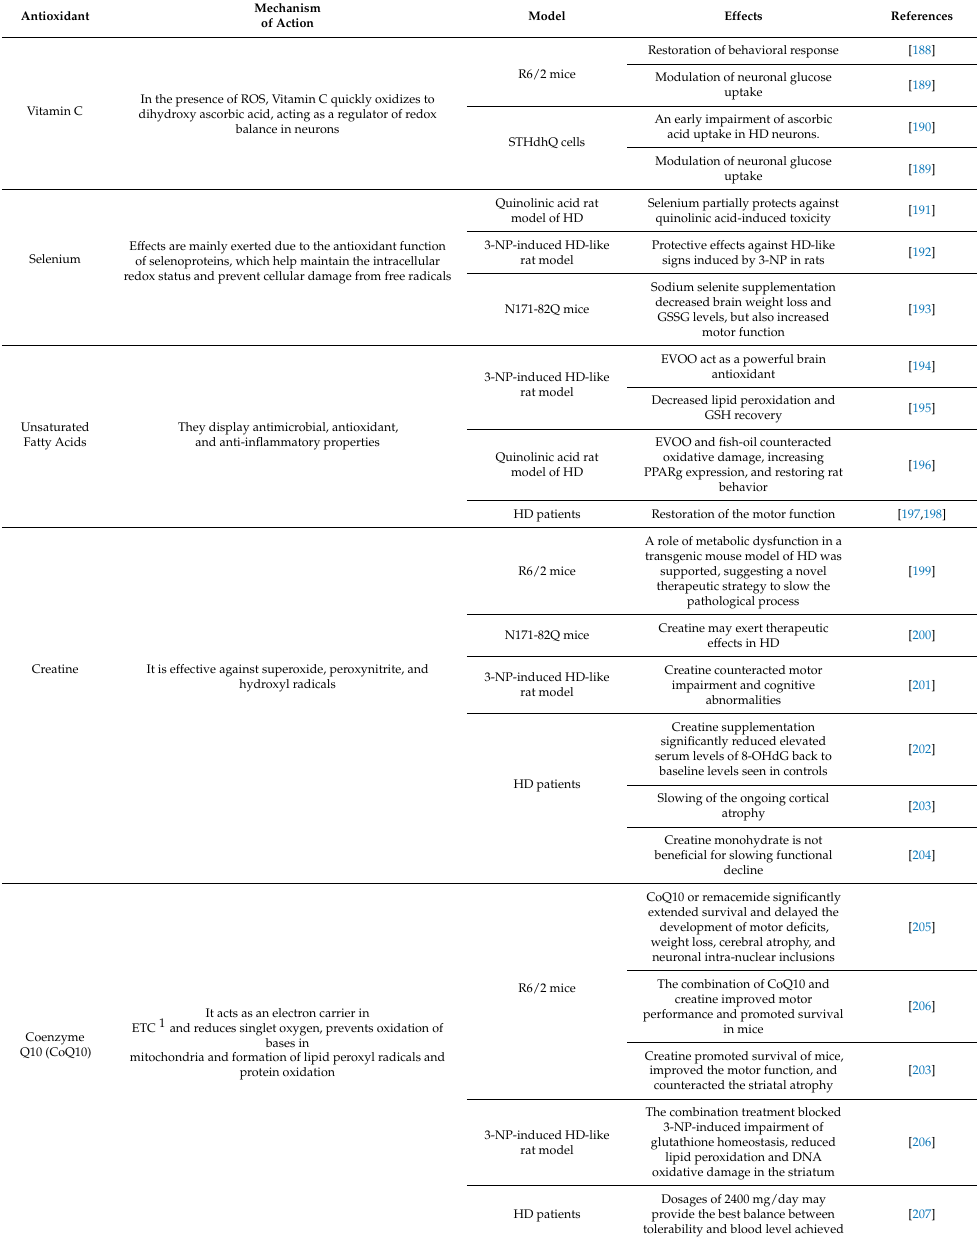
Table 1. Overview of antioxidant compounds explored in this review with a potential role in HD